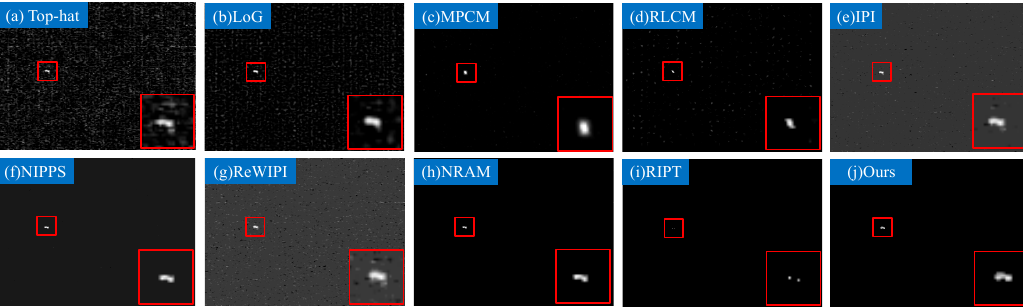
Figure 16. Results of the different approaches to Sequence 2.